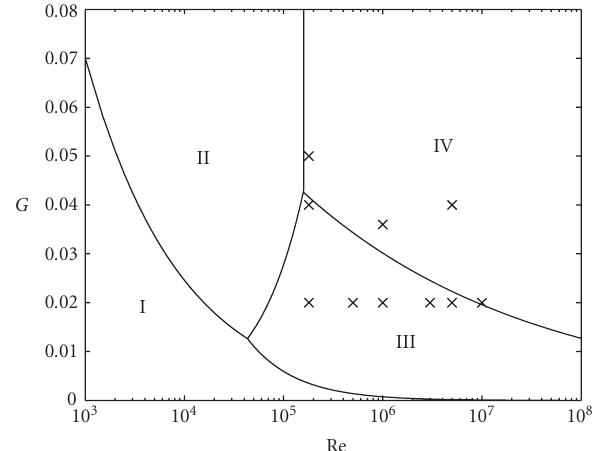
Figure 1: Diagram of the four-flow regimes according to Daily and Nece [1] with the cases considered here (cross-symbols).